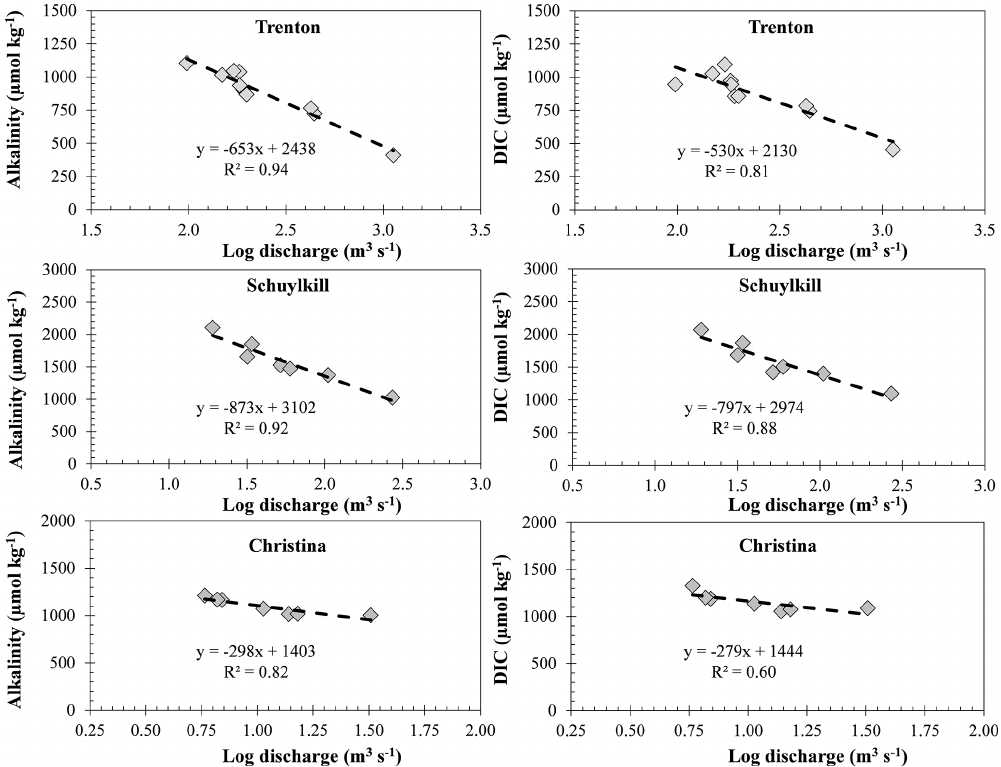
Figure 4. Alkalinity and DIC versus log discharge at the Delaware (Trenton), Schuylkill, and Christina rivers. Note the different scales used for each river. Table 2. Estimated TA and DIC in the Delaware (Trenton), Schuylkill, and Christina rivers, calculated by linear regression using discharge and their input fluxes to the Delaware